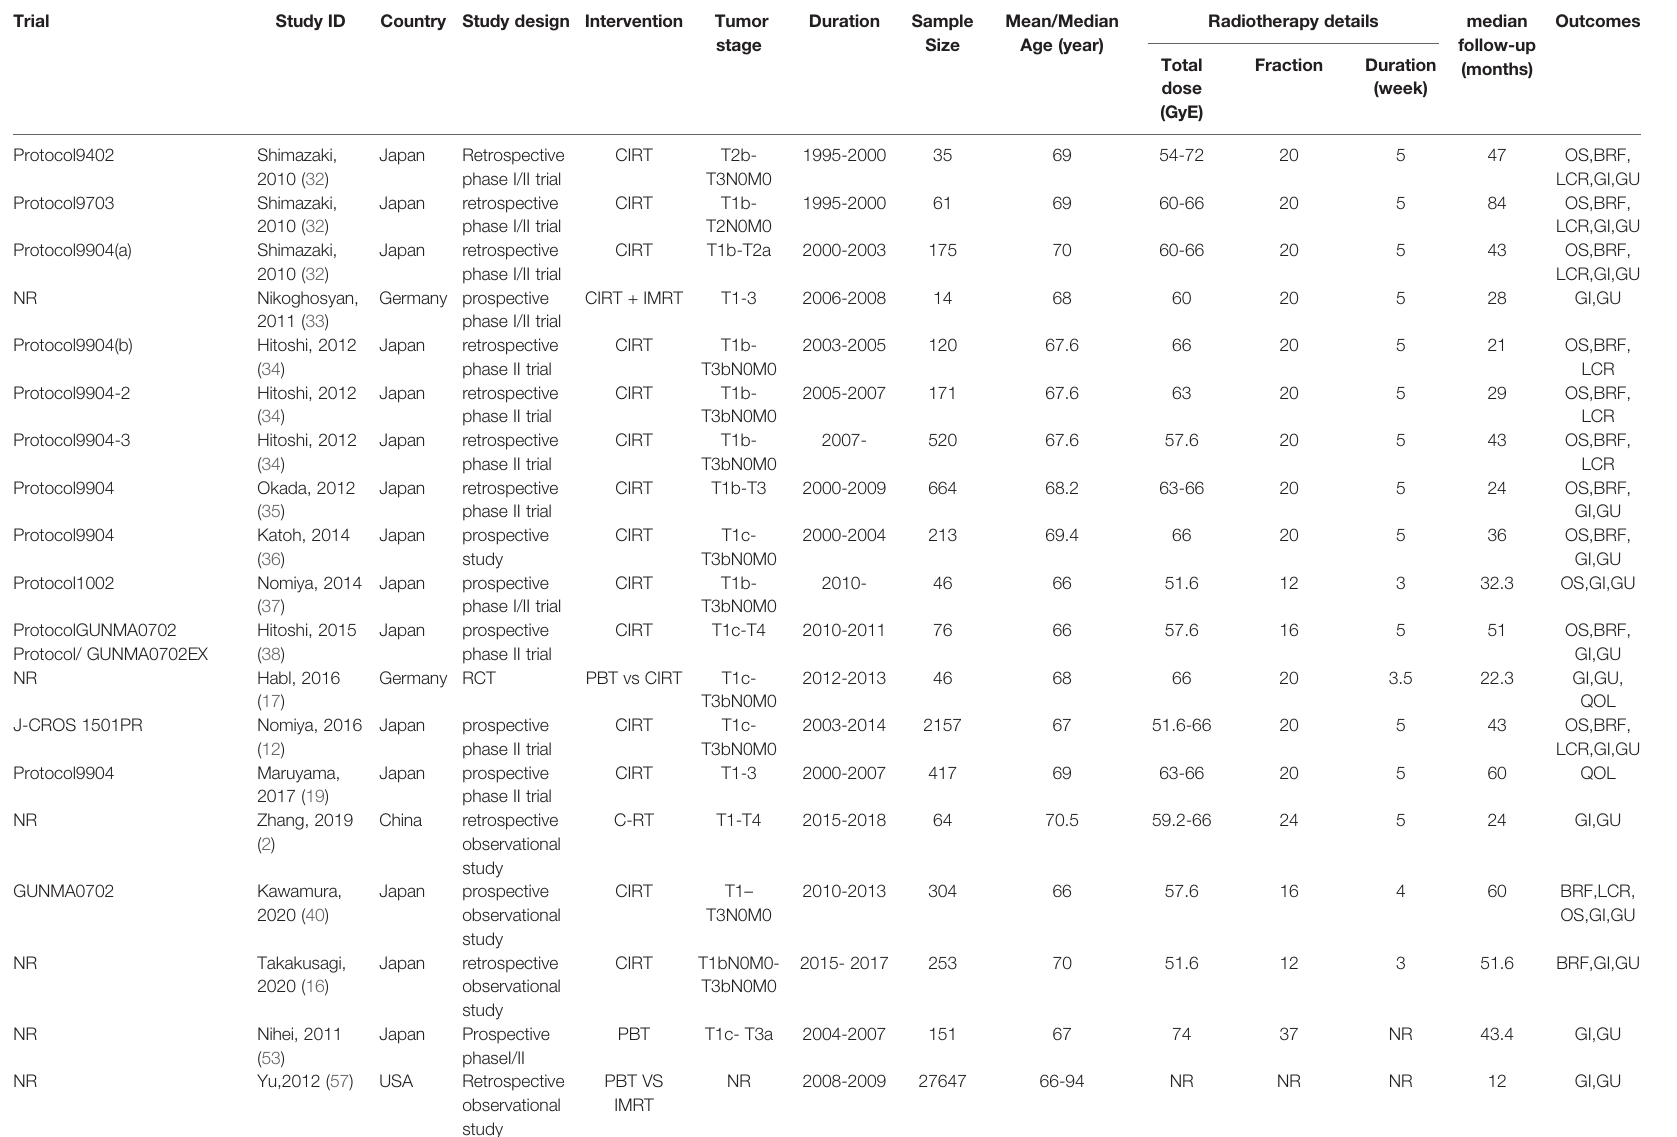
TABLE 1 | Basic characteristics of included